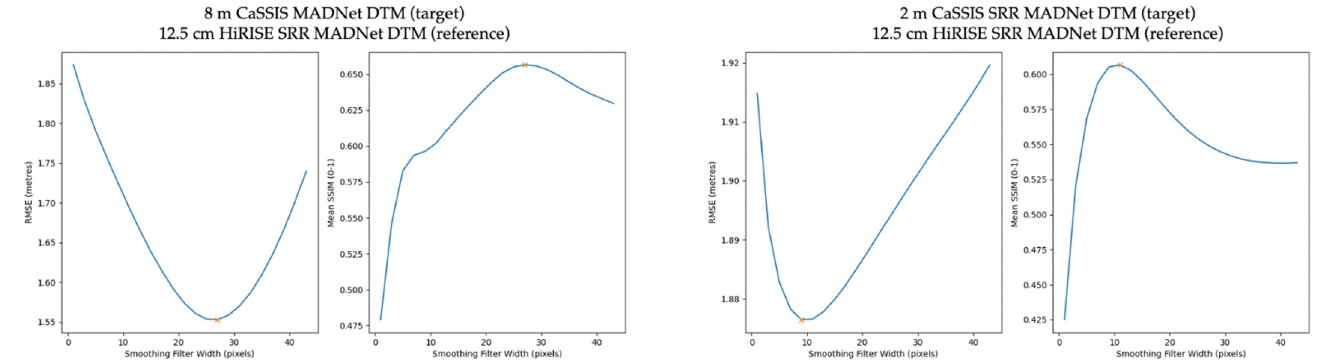
Figure 10. Left: RMSE and SSIM plots of the target 8 m/pixel CaSSIS MADNet DTM and the refer- Figure 10. Left : RMSE and SSIM plots of the target 8 m/pixel CaSSIS MADNet DTM and the ence 12.5 cm/pixel HiRISE SRR MADNet DTM; Right: RMSE and SSIM plots of the target 2 m/pixel reference 12.5 cm/pixel HiRISE SRR MADNet DTM; Right : RMSE and SSIM plots of the target CaSSIS SRR MADNet DTM and the reference 12.5 cm/pixel HiRISE SRR MADNet DTM. 2 m/pixel CaSSIS SRR MADNet DTM and the reference 12.5 cm/pixel HiRISE SRR MADNet